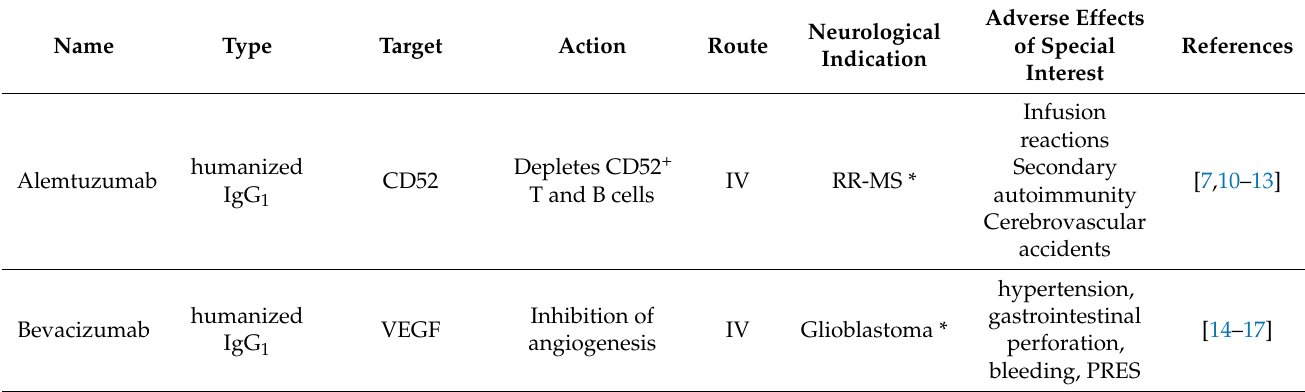
Table 1. Marketed monoclonal antibodies used in